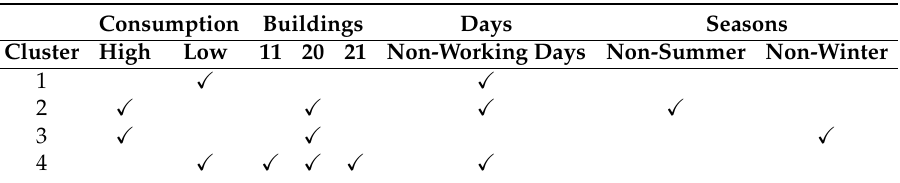
Table 5. Cluster analysis for four clusters.